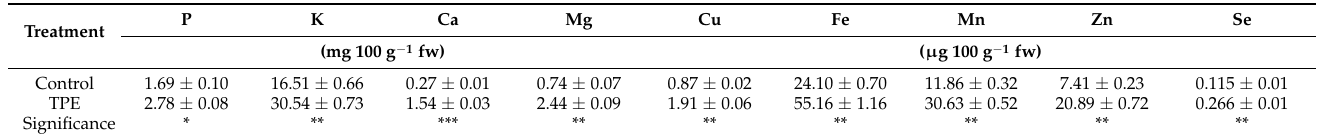
Table 3. Macro- and micronutrients content of San Marzano tomato fruits under control or tropical plant extract (TPE)